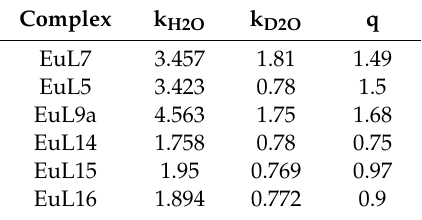
Table 2. Radiative decay constants and hydration numbers for Europium complexes.